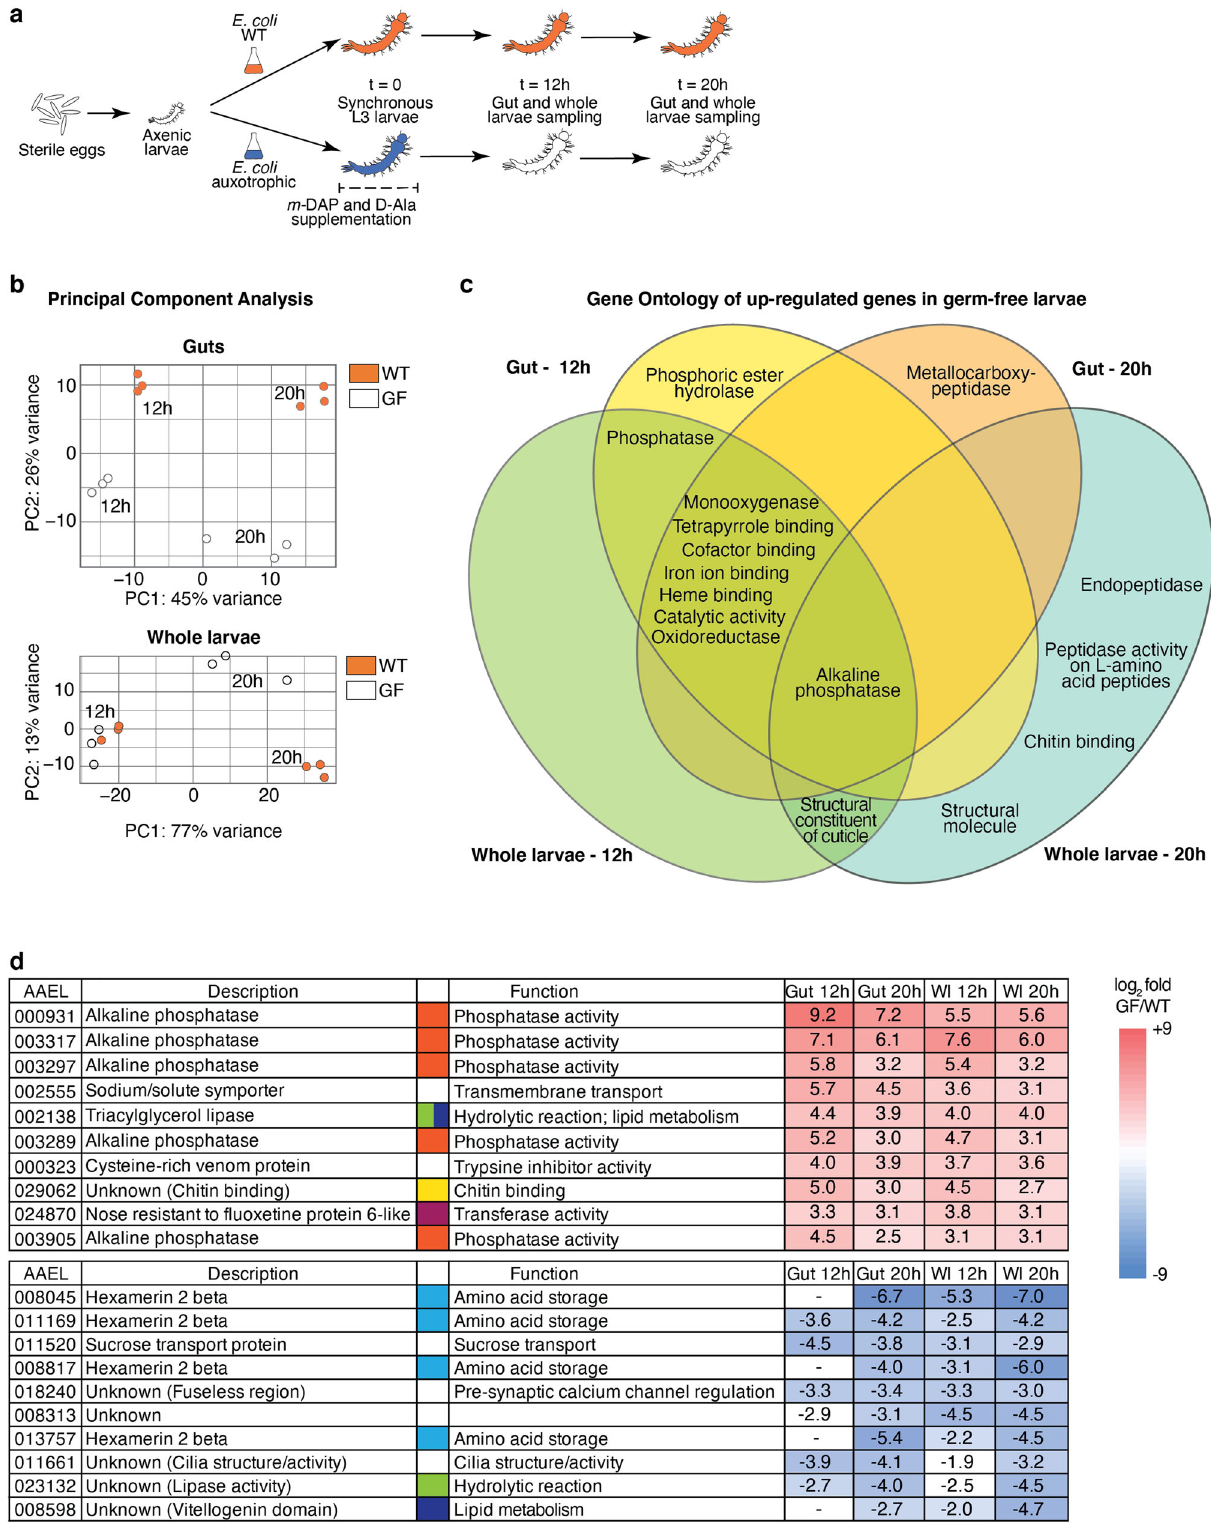
throughout the third instar. After extraction of total RNA, we con fi rmed the loss of bacteria in reversibly colonised mosquitoes libraries were produced and sequenced on an Illumina NextSeq